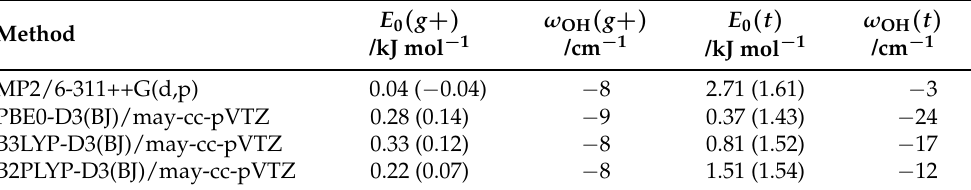
Table 1. Differences between α -fenchol conformers relative to g − for harmonically zero-point cor- rected energies and harmonic OH stretching wavenumbers at different computational levels. For values in parentheses, the electronic contributions to the energy difference were replaced with DLPNO-CCSD(T)/aug-cc-pVQZ single-point values calculated on the respective geometries. A sys- tematic underestimation of OH stretching wavenumber differences between g and t conformers of alcohols at MP2 level was reported before